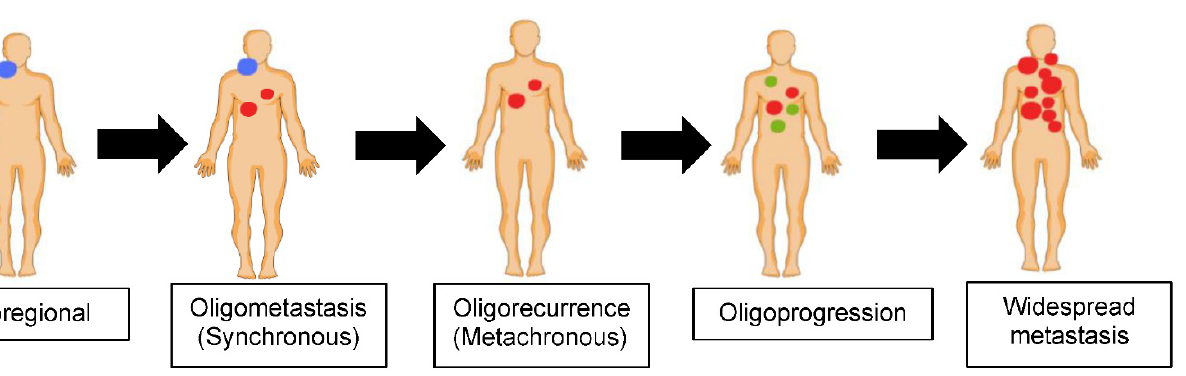
Figure 1. Metastatic disease spectrum.